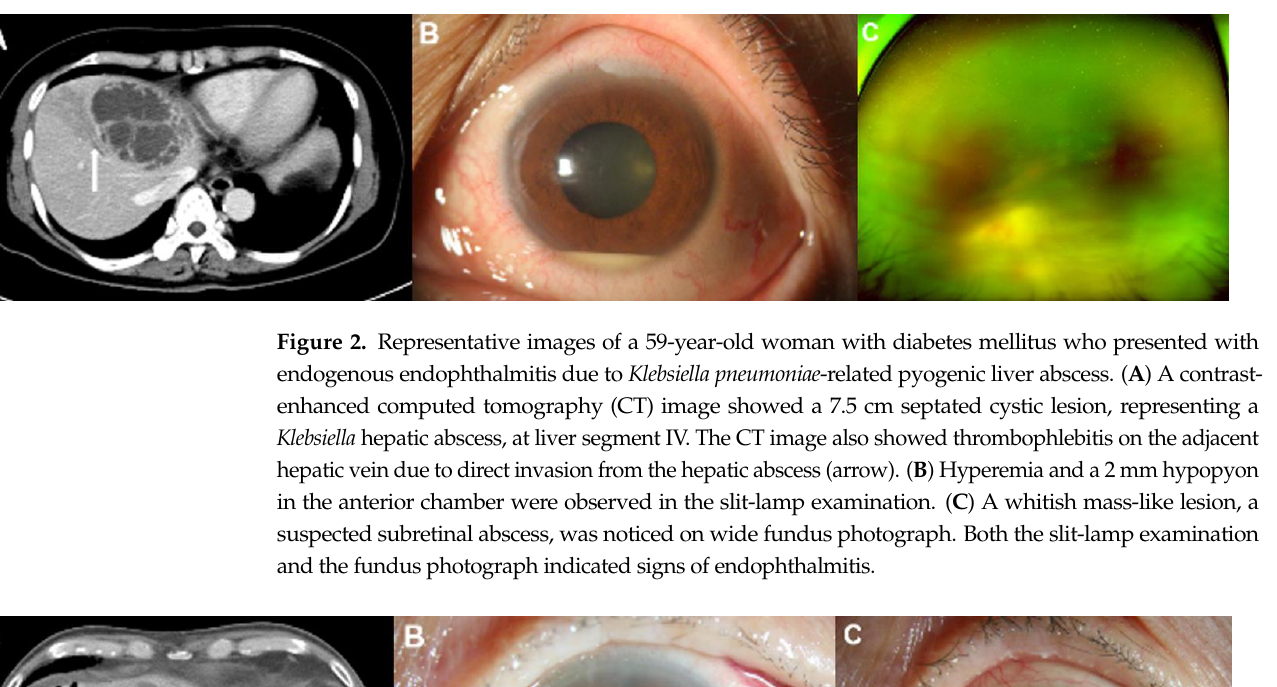
0.002 b, * EE = endogenous endophthalmitis. a The p -value was obtained via the Student ’s t-test. b The p -value was obtained via the Fisher’s exact test. c The p -value was obtained via the Chi-square test. * indi- cates statistically significant differences at p < 0.05. 3.3. Clinico-Radiologic Predictors for EE Univariate and multivariate logistic regression analyses were performed to identify the predictors of EE. In the univariate logistic regression analysis, left-lobe location ( p = 0.006, odds ratio (OR) = 5.651), location in both lobes ( p = 0.013, OR = 7.417), the involve-